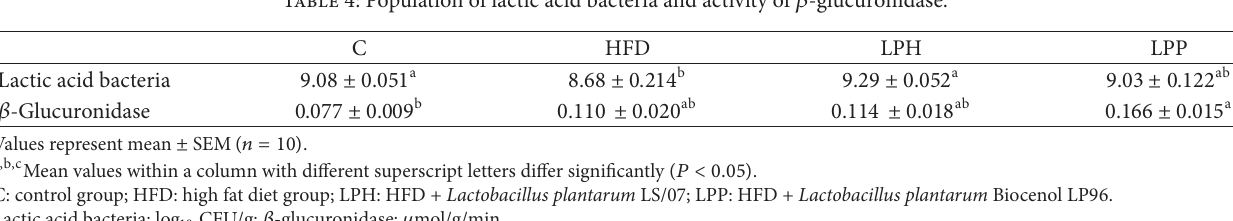
Table 4: Population of lactic acid bacteria and activity of 𝛽